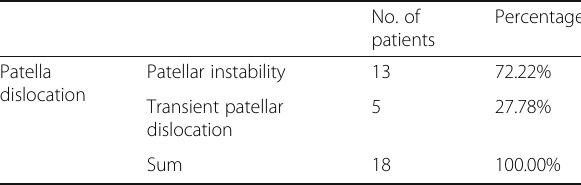
Table 11 Demonstrating the statistically calculated minimum, maximum, median, and the mean values of the trochlear groove depth by mm, trochlear facet asymmetry by %, and the lateral inclination angle by ° Depth of trochlear Trochlear facet Lateral inclination groove by mm asymmetry by % angle by° Table 12 Demonstrating the percentage of the patellar instability and the transient patellar